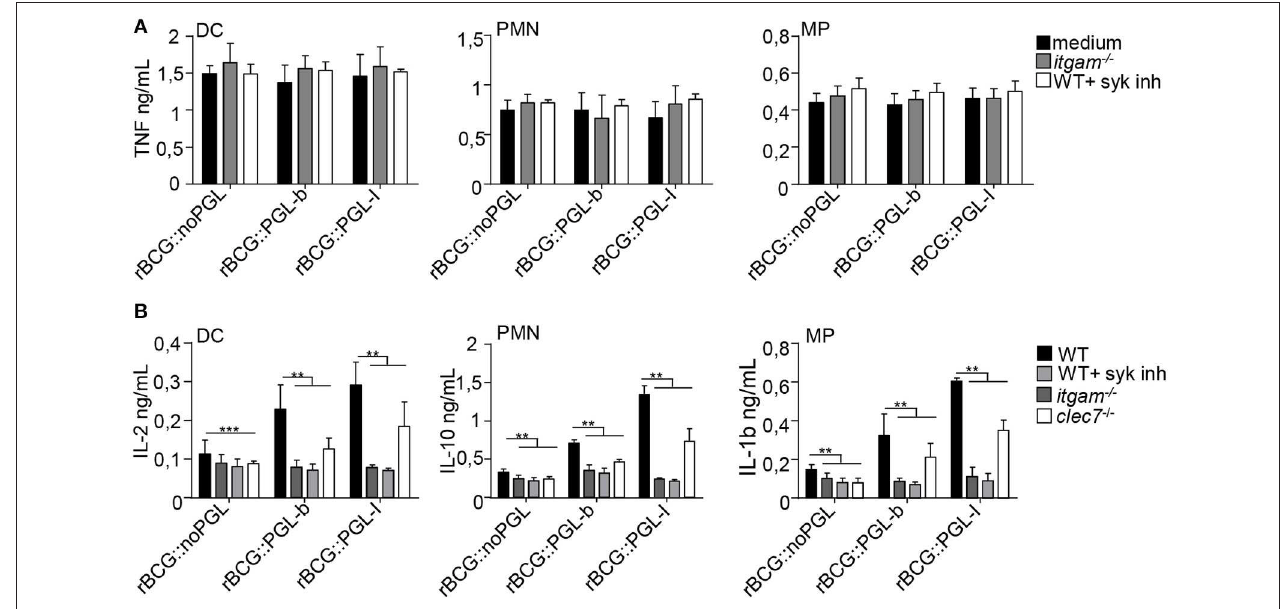
FIGURE 3 | CR3-mediated infection by rBCG::PGL-I induces Syk-dependent NF- κ b independent cytokines. (A) TNF produced in supernatants of DCs, PMNs or MPs derived from bone marrow of WT mice, treated with DMSO (vehicle), or 1 µ M of the Syk inhibitor GS-9973, and itgam − / − mice was determined by ELISA after overnight infection with the three rBCG strains at MOI of 5 under non-opsonizing conditions ( n = 8). (B) IL-2 produced by DCs, IL-10 by PMNs and IL-1 β by MPs from WT cells treated with DMSO, or 1 µ M of the Syk inhibitor GS-9973 or itgam − / − or clec7a − / − cells infected as in (A) were determined by ELISA ( n = 4). Data are presented as mean ± SEM. ** P < 0.01; *** P <